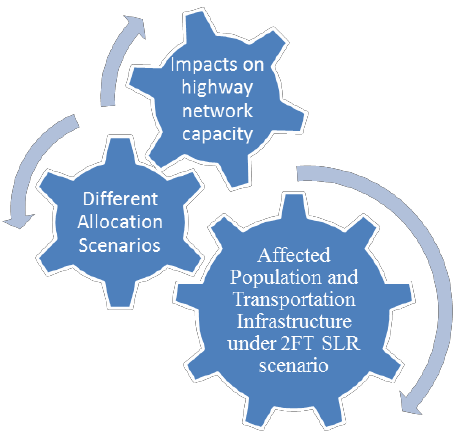
Figure 4 the main elements of the research design of the study